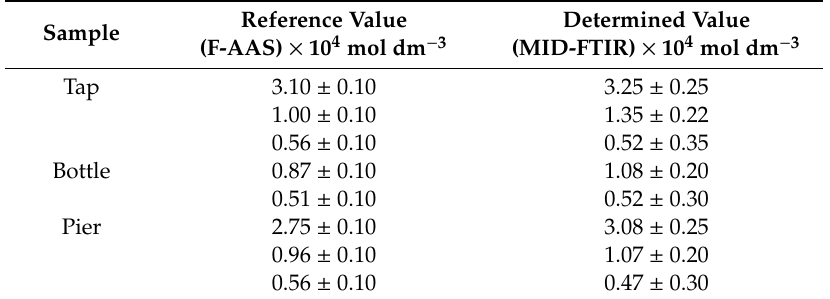
Table 4. Results of the analysis of cadmium (II) in real water samples spiked with the